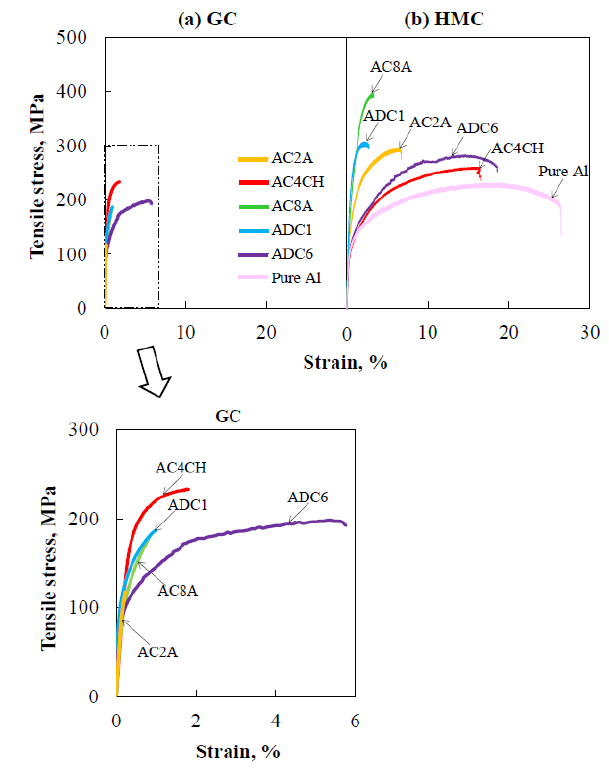
Figure 5. Representative tensile stress versus tensile strain curves for cast aluminum alloys: ( a ) GC and ( b )